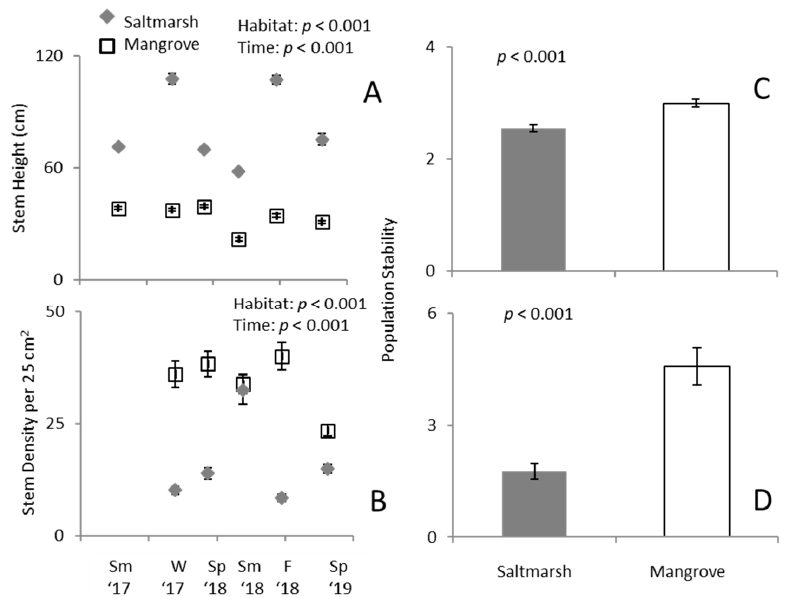
Figure 2. ( A ) Vegetation height, ( B ) density, and stability of ( C ) vegetation height and ( D ) density in saltmarsh (dark grey symbols and bars) and mangrove (white symbols and bars) habitats over the two-year predator exclusion experiment. Significant results are reported in the inset panels. Since experimental treatment was not significant for any metric, data from control and predator exclusion plots were pooled. Data are shown as the mean ± SEM for 10 plots per habitat type.